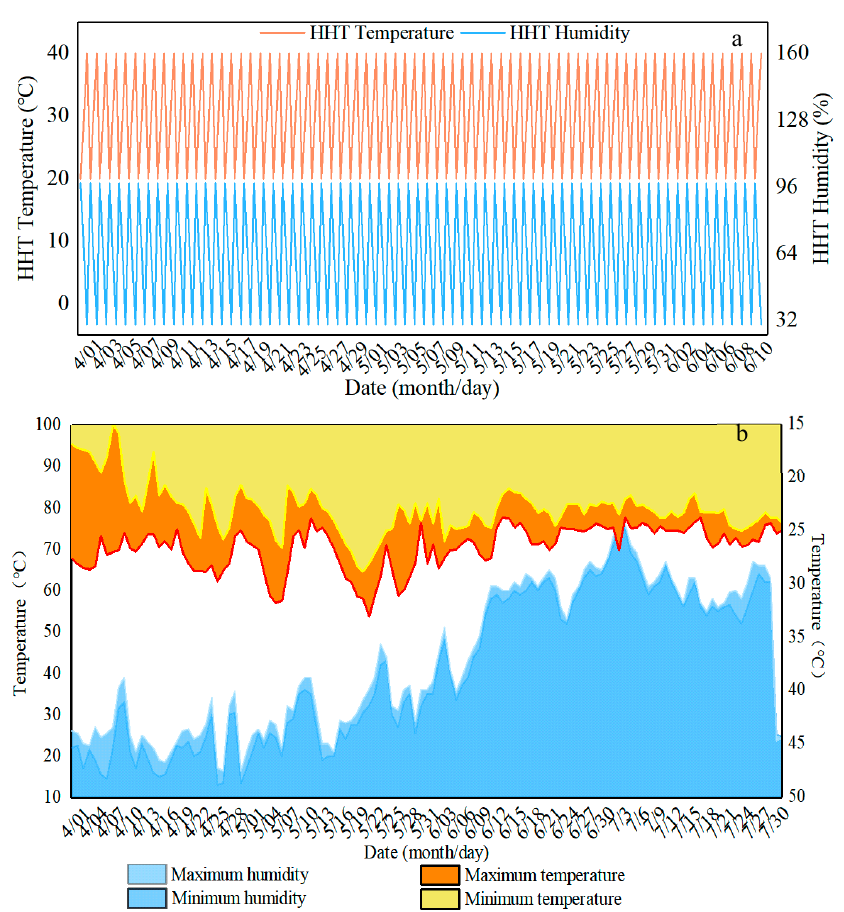
Figure 1. Humidity heat and natural ageing temperature and humidity monitoring. ( a ) treatment group. ( b ) Control group.